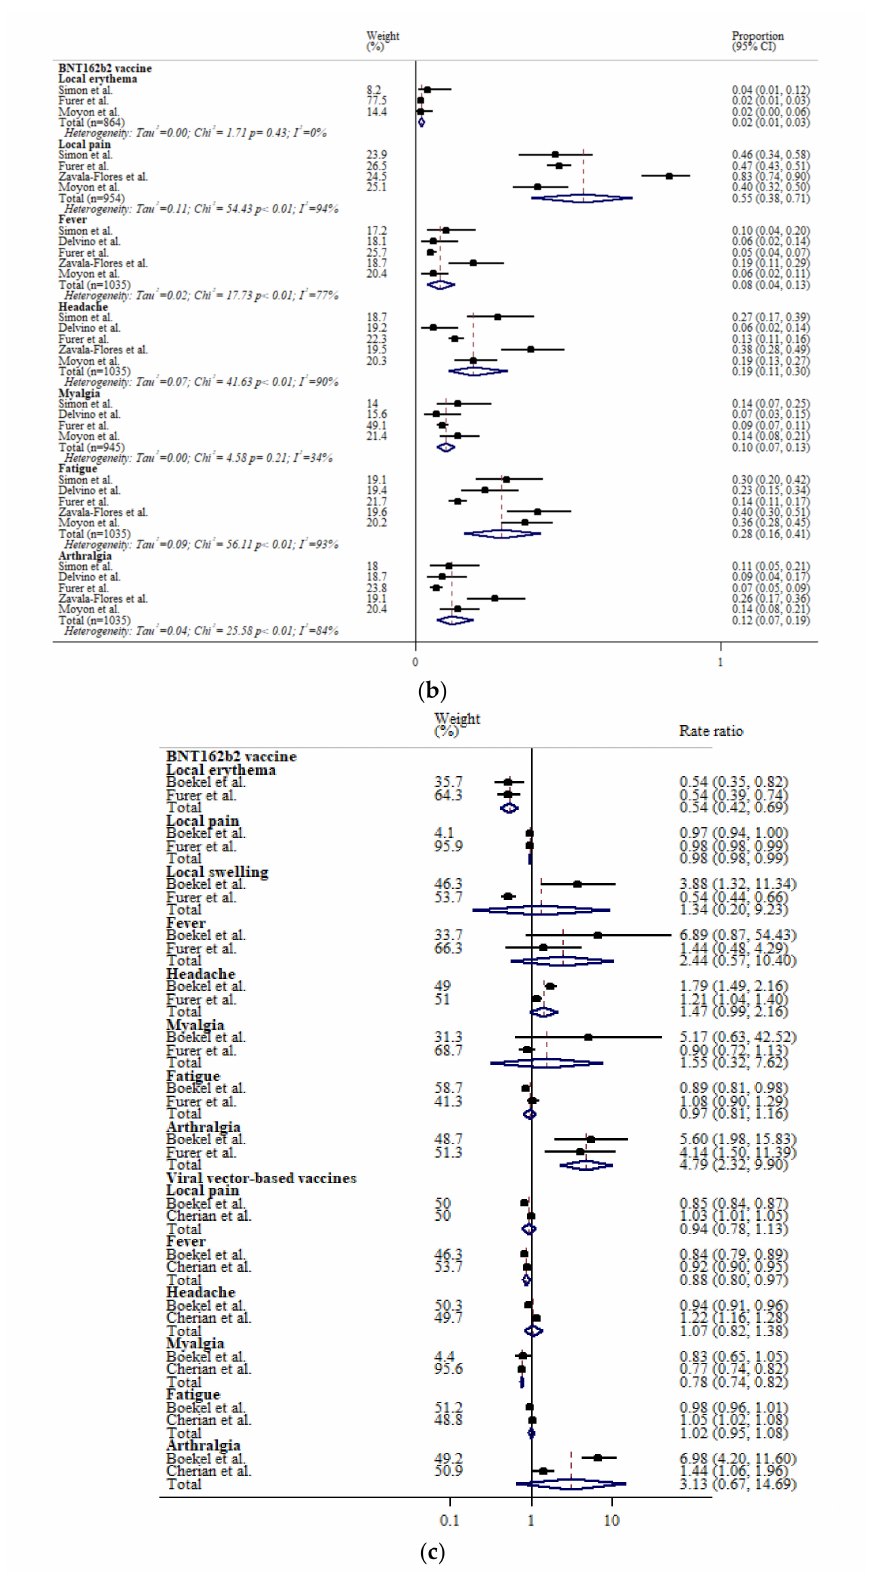
Figure 4. The incidence rate of adverse events after the ( a ) first and ( b ) second dose of COVID-19 vaccines in rheumatic patients, and the ( c ) incidence rate ratios of adverse events after the first dose of COVID-19 vaccines between rheumatic patients and healthy controls. The black squares represent the effect estimates of the individual studies and the diamonds represent the summary effect